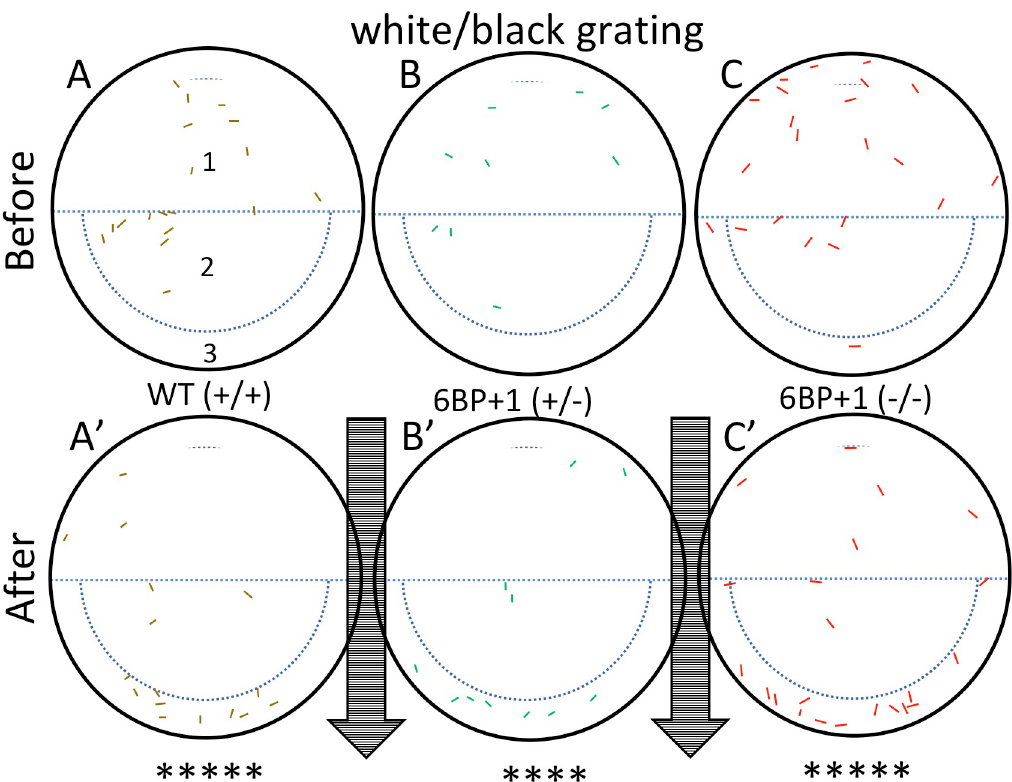
Fig 11. Optomotor response test using a black/white stimulus. Controls use a drifting black and white grating pattern with wild types (+/+) (N = 18 larvae), 6BP+1 heterozygotes (+/-) (N = 12 larvae), and 6BP+1 mutants (-/-) (N = 23 larvae) at 7 dpf. Colored markings in the dishes represent larval zebrafish locations before and after the one-minute stimulus. The arrows indicate the direction of the stimulus. (A, B, C) Wild types, heterozygotes, and mutants respectively start scattered in the dish. (A’, B’, C’) Each genotype moved with the stimulus showing significant pooling of larvae at the bottom edge. Experiment was repeated 2 times per genotype, with similar outcomes for each trial. Significance, given by the Fisher Exact Test, refers to the combined numbers from the two plates (Table 2).